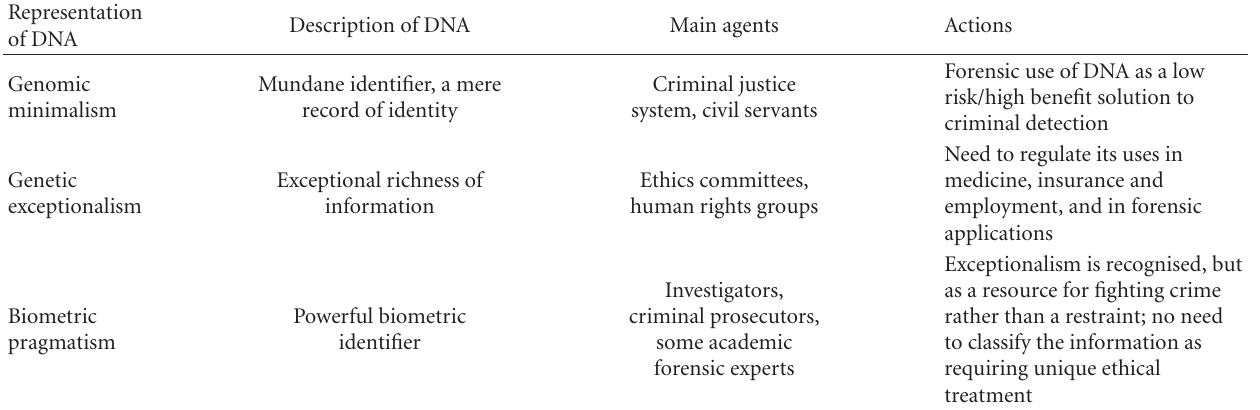
Table 1: Model for conceptualisation of meanings and uses attributed to